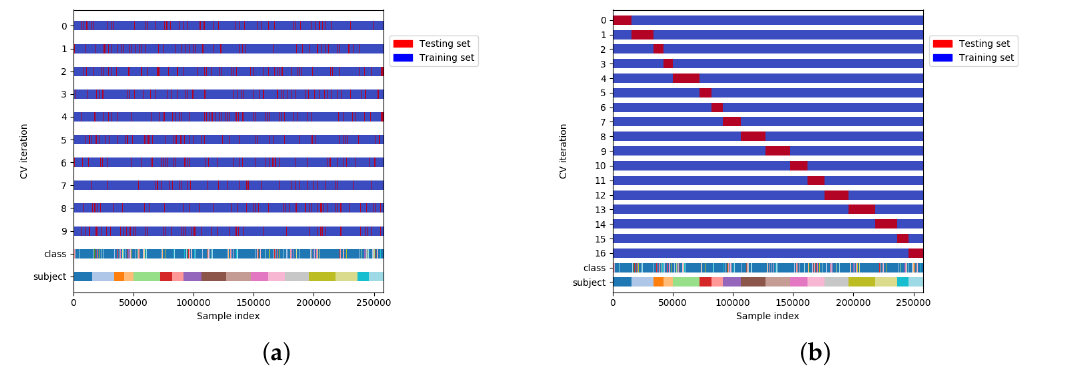
Figure 4. Different types of CV in HAR. ( a ) Subject-dependent CV; ( b ) Subject independent